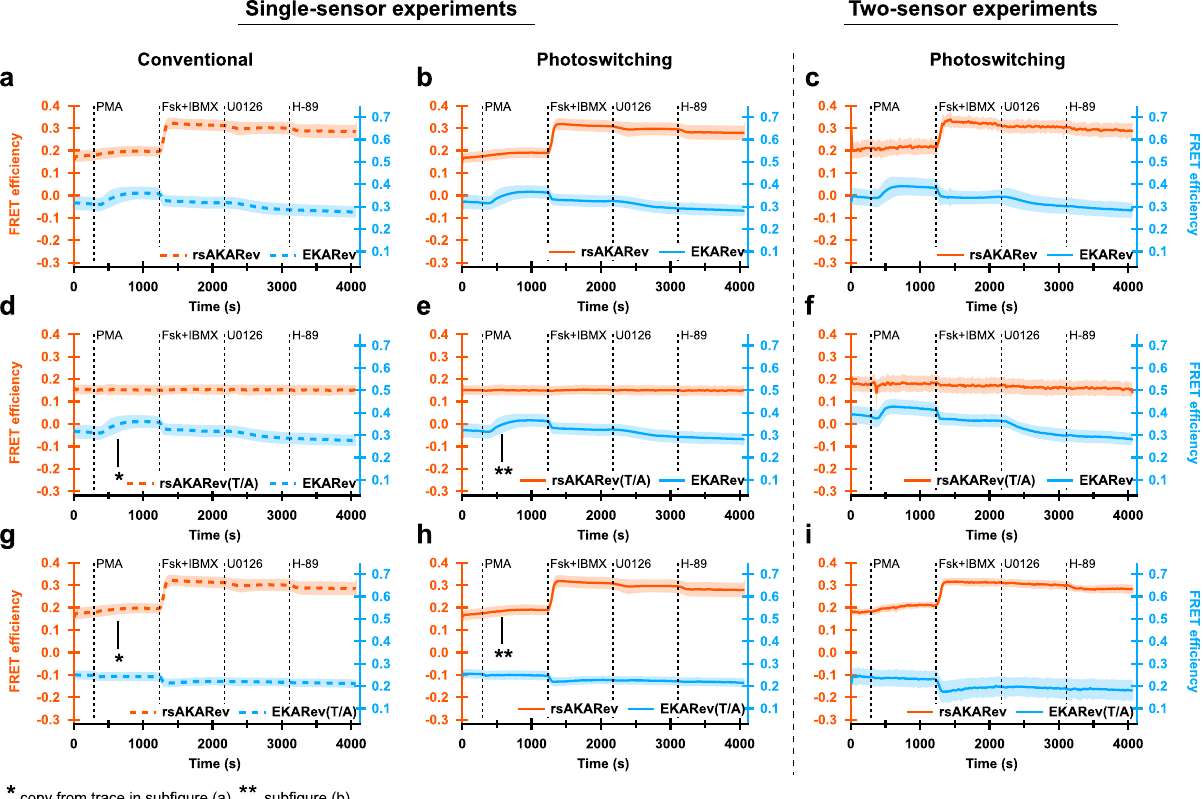
Fig. 5 Performance of our method in living cells expressing two overlapping FRET biosensors. PKA and/or ERK signaling responses in HeLa cells expressing one (left, middle panels) or two (right panels) FRET biosensors. Responses of rsAKARev, rsAKARev(T/A), EKARev, and EKARev(T/A) are depicted per column according to the method of analysis. Dashed traces indicate results obtained using conventional analysis based on sensitized emission, while solid traces indicate results obtained using the photoswitching-based analysis presented here. All traces represent average FRET ef fi ciencies plus standard deviation (shaded area). n = 75 (rsAKARev), 132 (EKARev), 12 (rsAKARev(T/A)), 42 (EKARev(T/A)) cells for single-sensor experiments and 80 (rsAKARev + EKARev), 50 (rsAKARev(T/A) + EKARev), 22 (rsAKARev + EKARev(T/A)) cells for two-sensor experiments, from 3, 2, 1, 1 and 2, 1, 1 independent experiments, respectively. Cells were stimulated with PMA (1 μ M), forskolin (Fsk, 50 μ M) and IBMX (100 μ M), U0126 (20 μ M), and H-89 (20 μ